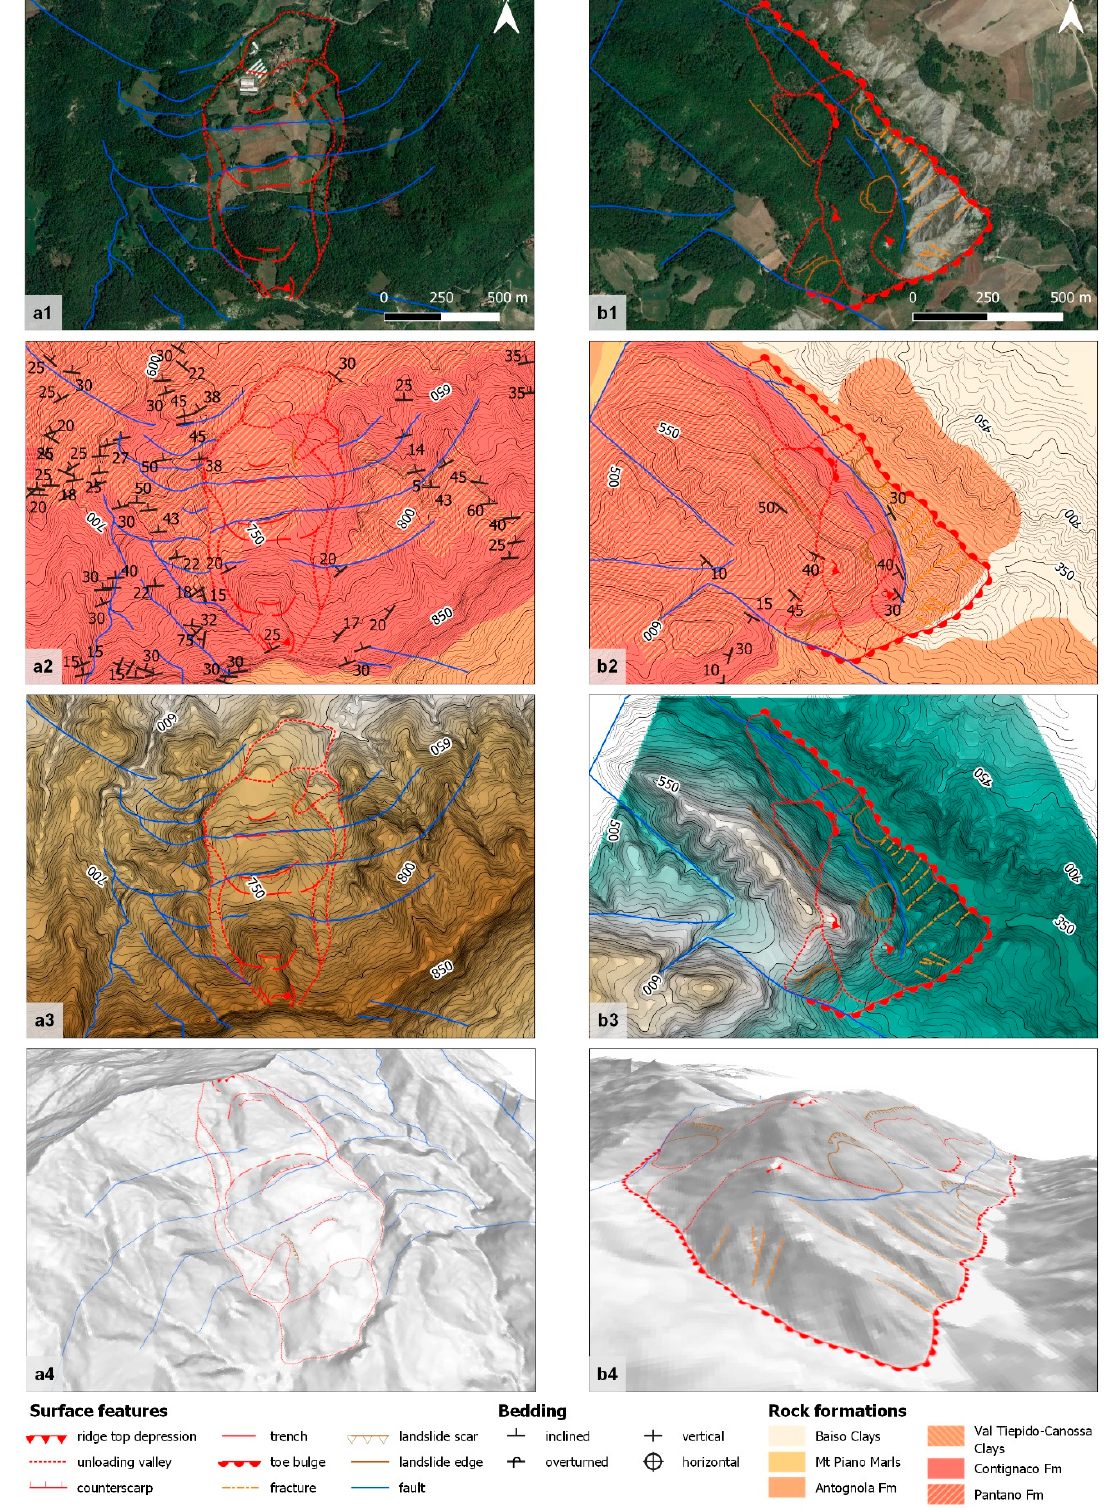
Figure 6. Detailed mapping of the DSGSDs in the Carpineti ridge area: ( a ) Carpineti; ( b ) Marola. For both landforms the main surface geomorphological features are represented on: ( 1 ) Google Earth™ satellite image (Google 2020, seen on 30 July 2020); ( 2 ) geological map at scale 1:50,000 [82]; ( 3 ) colorized DTM-slope layer mesh; ( 4 ) DTM-derived 3D model.